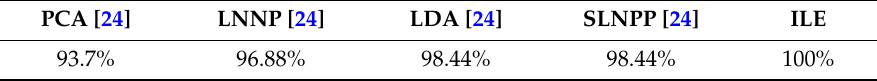
Table 3. Recognition rate of each